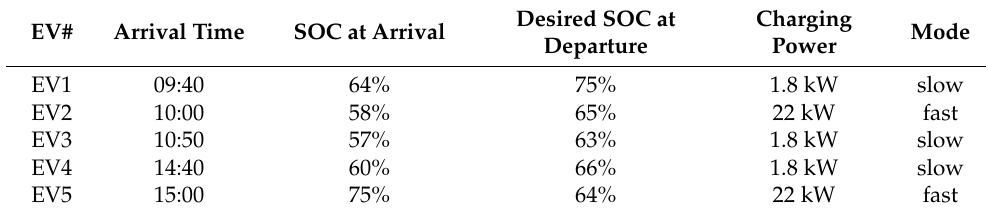
Table 5. Hypotheses for Scenario 2c.